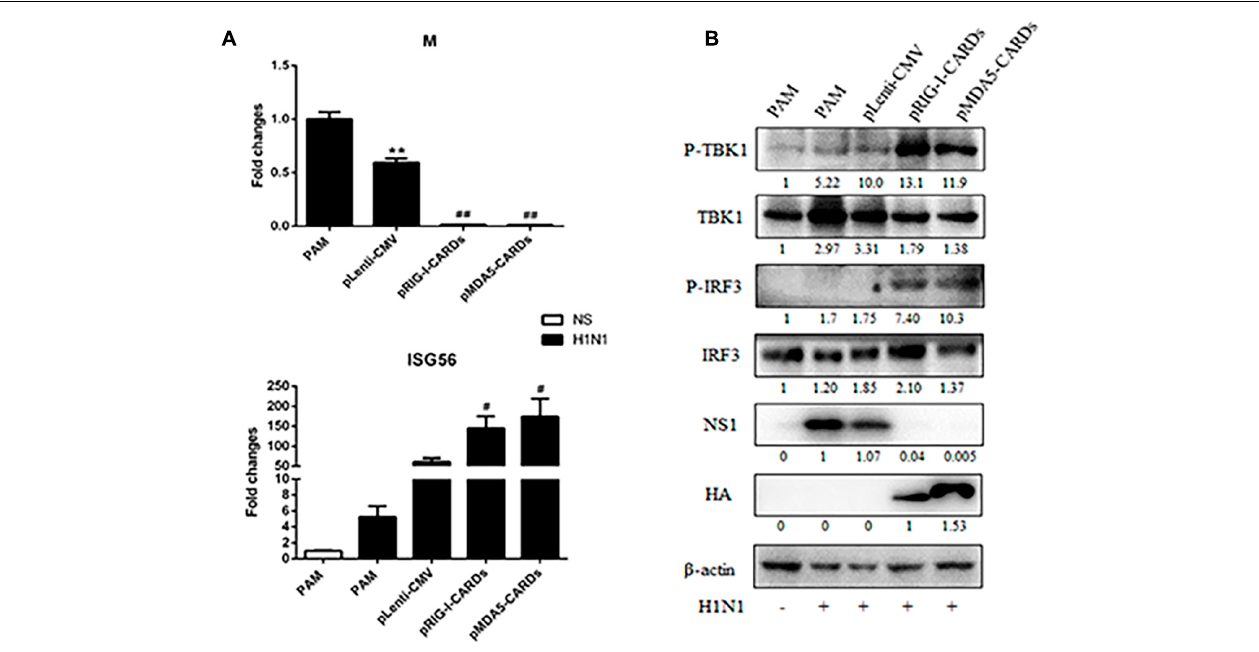
FIGURE 6 | The anti-influenza virus H1N1 activity of porcine RIG-I and MDA5 CARDs. PAMs grown on 24-well plates (3 × 10 5 cells/well) were transfected with CARDs expression plasmids and pLenti-CMV vector (0.5 µ g each) using TransIT-LT1 Transfection Reagent for 24 h. Then the cells were infected with H1N1 virus at MOI of 0.01 for 12 h. The cells samples were analyzed by RT-qPCR for viral M gene and downstream ISG56 gene expressions (A) or detected by Western-blotting using the indicated antibodies (B) . The densitometry values after actin normalization were shown below the blots. ** p < 0.01 vs. blank controls; # p < 0.05, ## p < 0.01 vs. vector